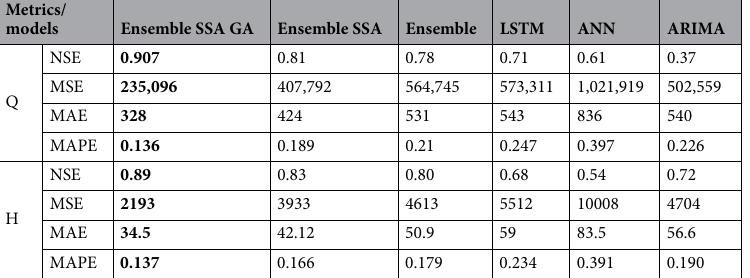
Table 9. Multi-step-ahead forecasting for Son Tay dataset. Best results are highlighted in bold text. Our proposed method (i.e., Ensemble SSA GA) outperforms the others.